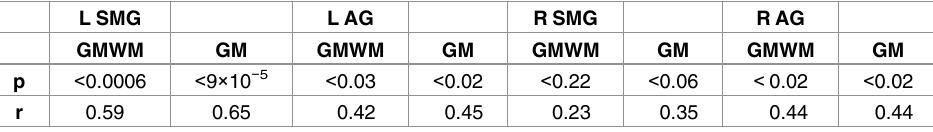
Table 10. Correlations between size of region (GMWM and GM) and number of additional gyri ( *